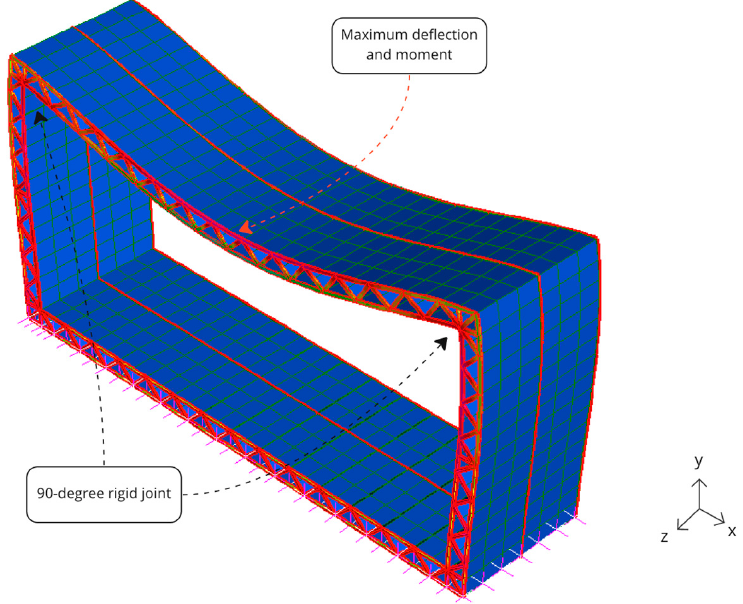
Figure 4. Deformed shape of DFF influenced by the dead and live loads.